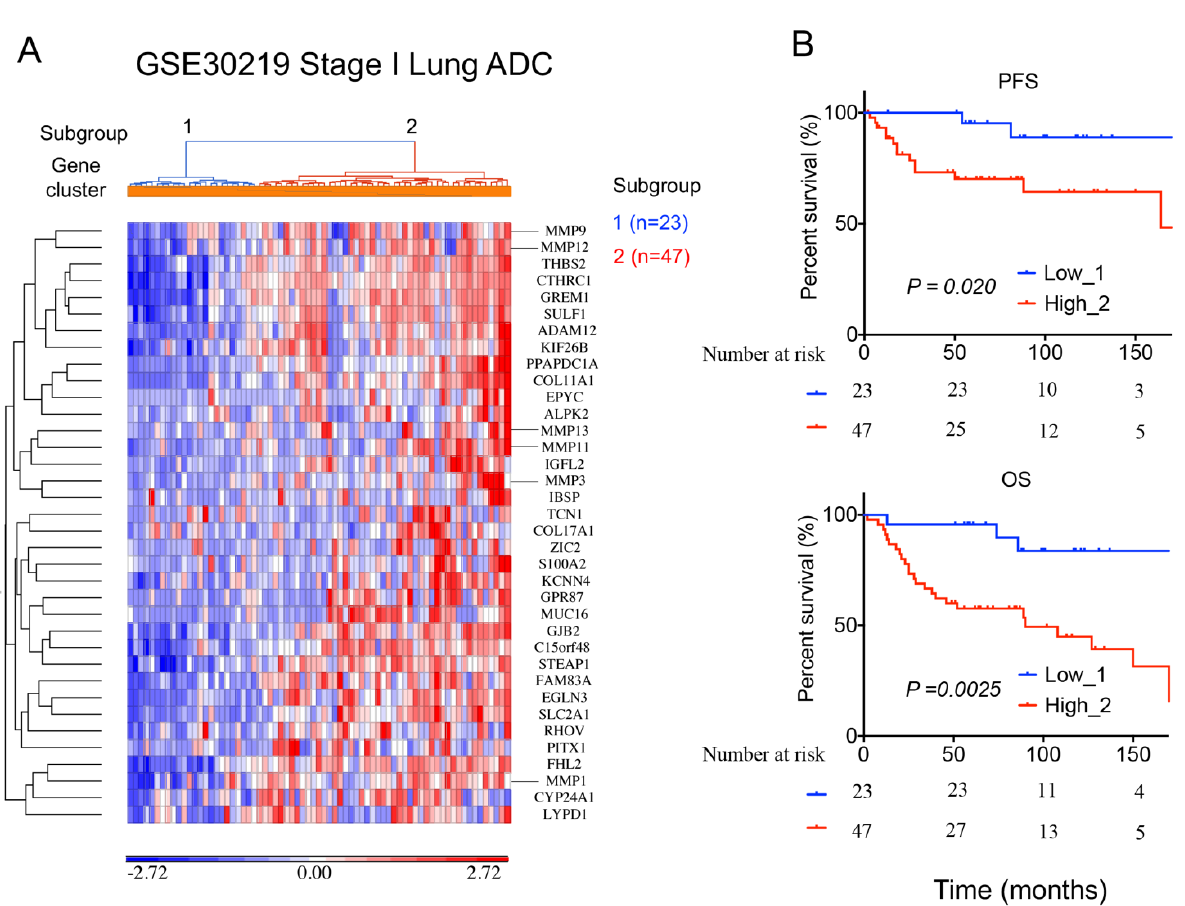
Figure 6. Validation of the 36-gene MMP signature in an independent GSE30219 lung cancer cohort; 70 stage I lung adenocarcinoma patient samples from the GSE30219 cohort were analyzed: ( A ) An unsupervised hierarchical clustering heatmap revealed two lung adenocarcinoma subgroups clus- tered with 36-gene MMP signature. ( B ) Kaplan–Meier survival analysis of patient subgroups based on the 36-gene MMP signature was performed using the log-rank test.